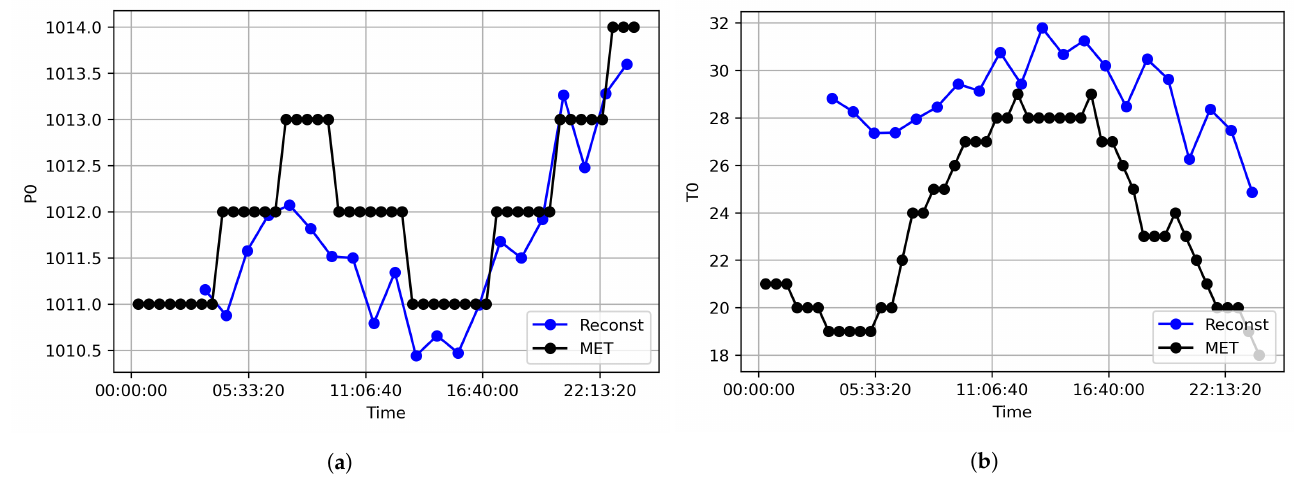
Figure 4. Vienna Airport Reconstructed Parameters Comparison. ( a ) Pressure p 0 Comparison. ( b ) Temperature t 0